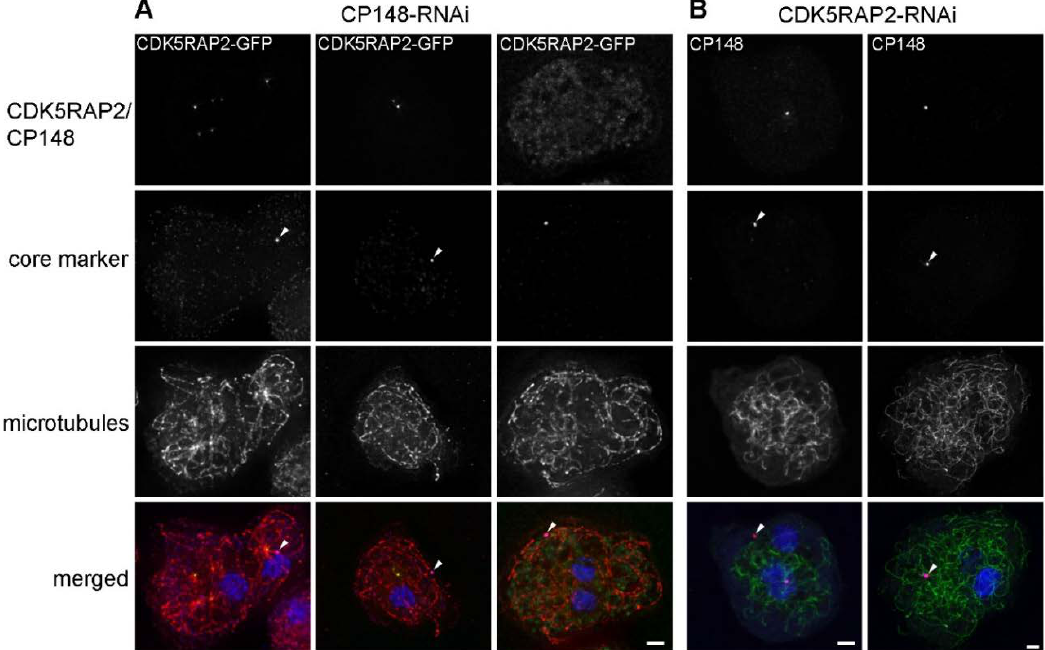
Figure 9. CDK5RAP2RNAi and CP148RNAi cause similar centrosome disruptions. Immunofluorescence microscopy of CDK5RAP2-GFP/CP148RNAi ( A ) and GFP-TubA/CDK5RAP2RNAi ( B ) cells stained with the indicated antibodies. DNA-staining with DAPI is shown in the merged images. In ( A ) primary and secondary antibodies were anti- α -tubulin/anti-rat-Atto647n and anti-Cep192 (core marker; arrowhead)/anti-rabbit-AlexaFluor 568, in ( B ) anti-CP55 (core marker; arrowhead)/anti-rat-AlexaFluor 568 and anti-CP148/anti-rabbit-Alexa 647. Cells were fixed with methanol. Maximum intensity projections of deconvolved images are displayed. Bars = 2 µm.